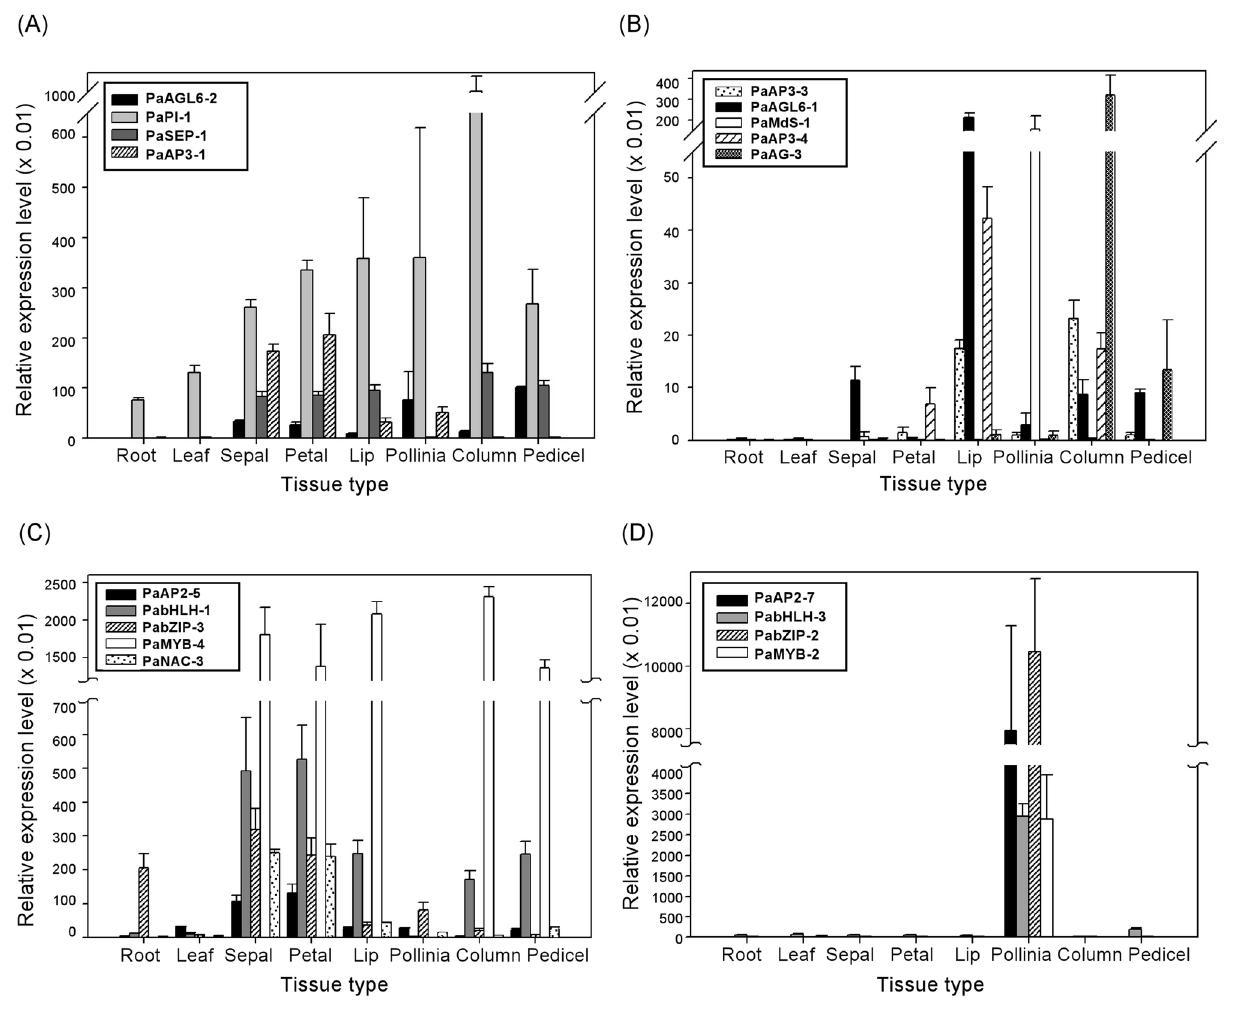
Figure 4. Quantitative PCR validation of orchid transcription factors with floral organ-specific expression patterns. (A) Relative expression levels of MADS box genes expressed across floral organs. (B) Relative expression levels of MADS box genes with floral organ-specific expression patterns. (C) Relative expression levels of AP2 , bHLH , bZIP and NAC that are generally expressed across floral organs. (D) Relative expression levels of transcription factor genes with pollinia-specific expression patterns. Primers used in the PCR reactions are listed in Table S3 in File